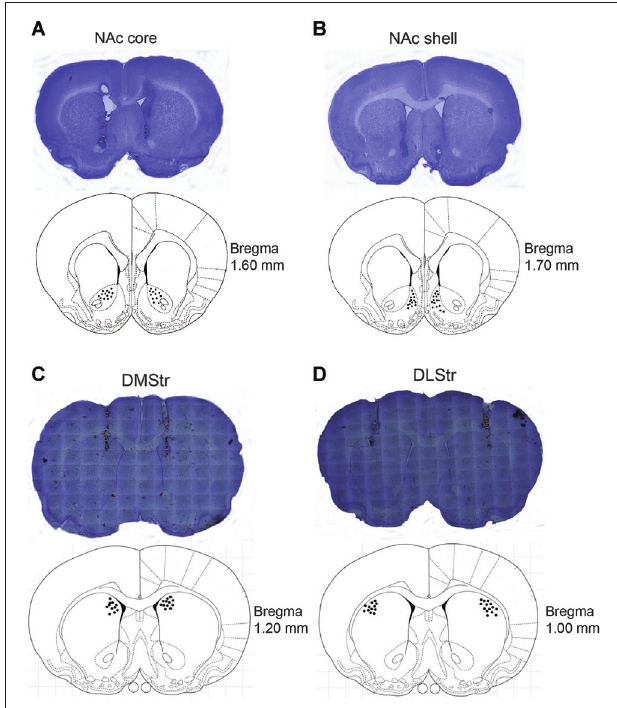
FIGURE 1 | Images showing cannula tracks and needle-tip locations in the NAc core (A), NAc shell (B), DMStr (C), and DLStr (D) . After the behavioral tests, the rats were sacrificed. Brains were removed and fixed in a 4% formalin solution. The brain slices were collected in 50 µ m coronal sections prior to being mounted and stained with Nissl staining solution. Images are shown on the top of each pattern. The distribution of the infusion sites was plotted on drawings of coronal sections from the Paxinos and Watson (1997) atlas. NAc, nucleus accumbens; DMStr, dorsomedial striatum; DLStr, dorsolateral